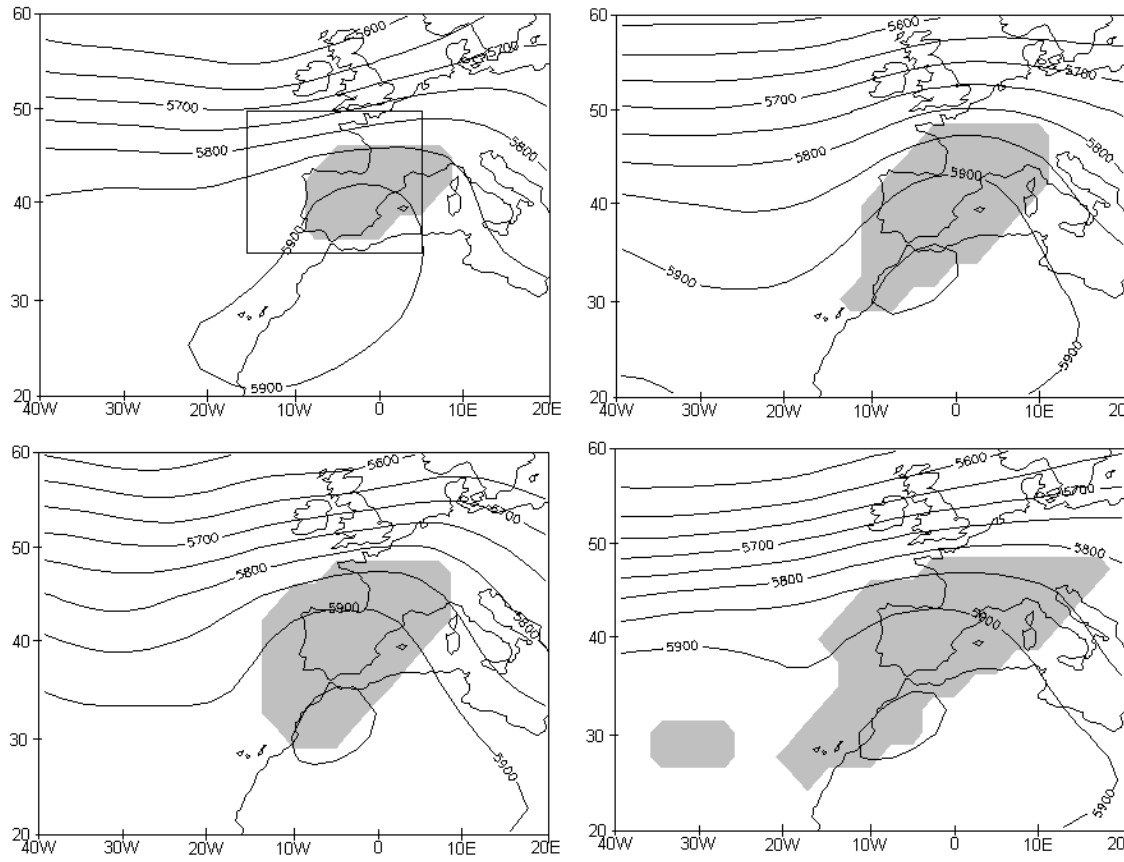
Fig. 10. (a) Z 500 composites (June to September) for the period of 1955–1965. Shadowed area represents values with anomalies higher than one standard deviation. The square shows the area used to compute CI (see text for details). (b) (a) , but for the period of 1966–1976. (c) (a) , but for the period of 1977–1987. (d) (a) , but for the period of